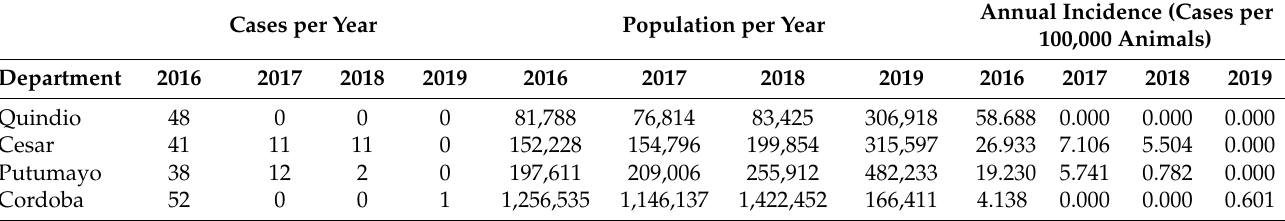
Table 2. Bovine rabies cases, bovine population and bovine rabies annual incidence per departments, Colombia,